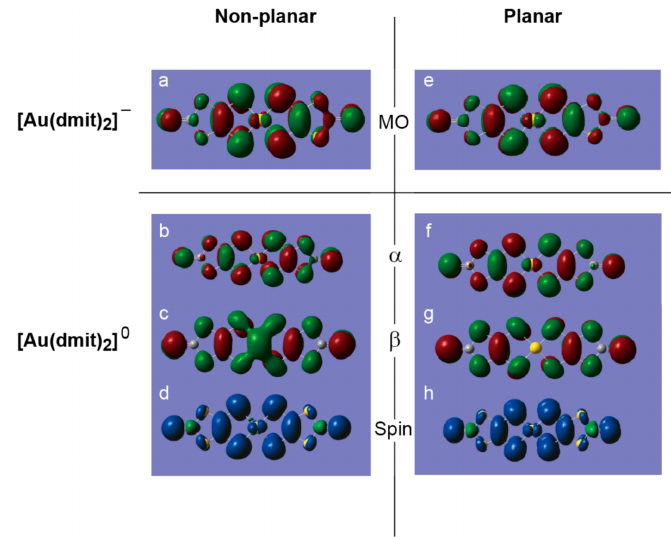
Figure 13. DFT (density functional theory) calculations (B3LYP / LanL2DZ(5d,7f)) on P and NP [Au(dmit) 2 ] n − ( n = 0, 1) complexes based on the molecular structure determined at 100 K. Here